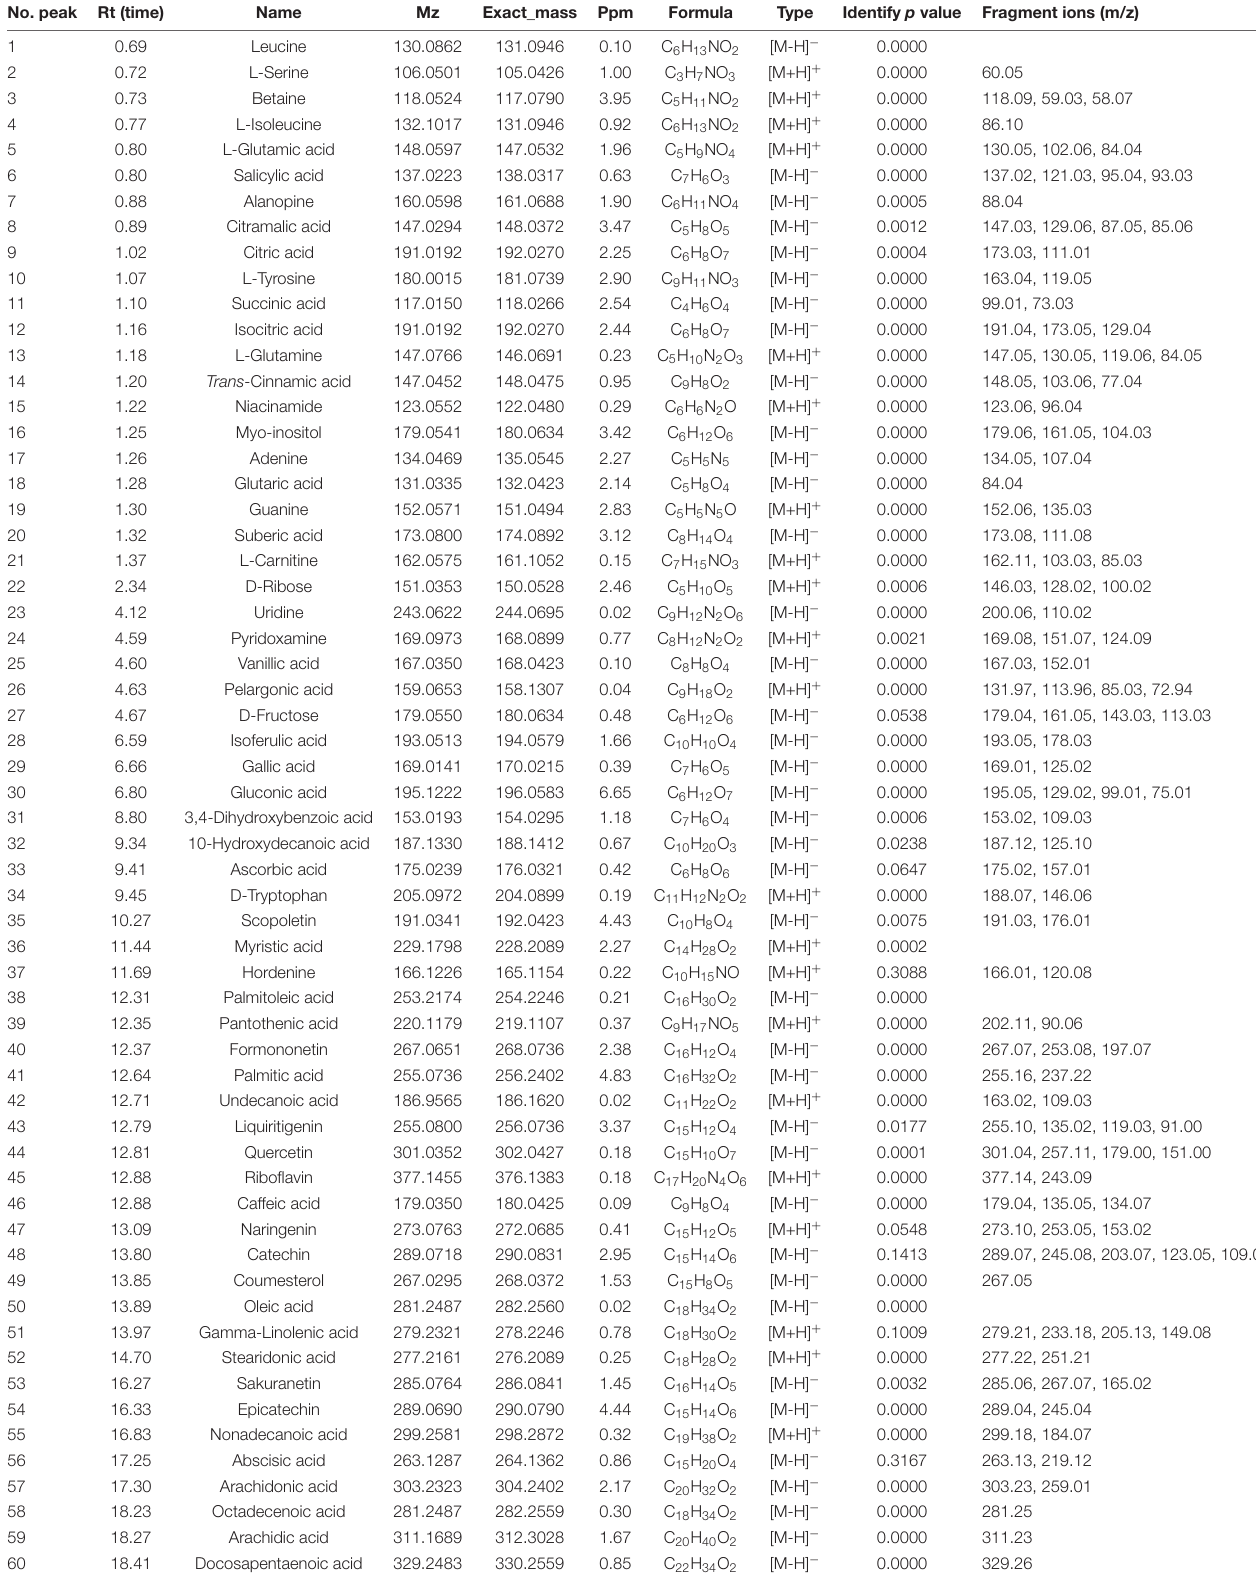
TABLE 1 | Characterization of bioactive components in P. vicina extract by UPLC-Q-Extractive Orbitrap MS. No. peak Rt